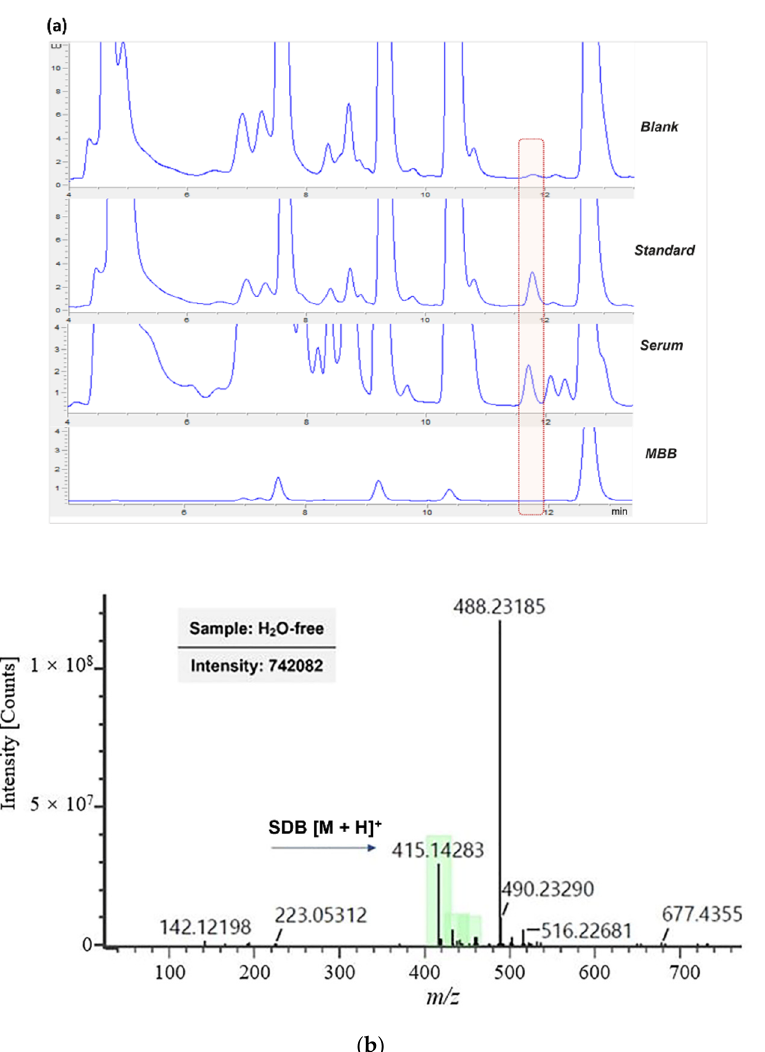
Figure 1. ( a ) Representative HPLC-FLD chromatograms of blank (H 2 O), standard solution (6 µM Na 2 S), serum, and MBB. ( b ) MS spectrum of H 2 S derivatives. The molecular ion of SDB [M + H] + is shown at 415.1 m / z .